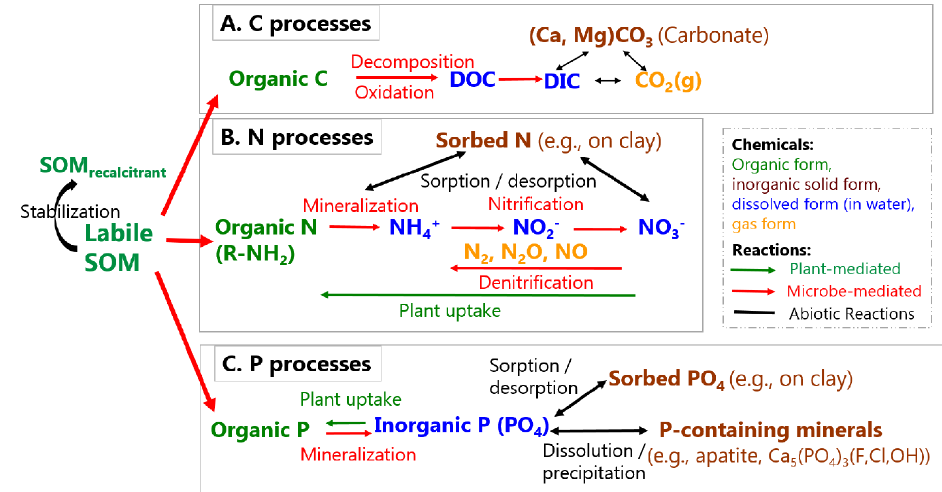
Figure 3. Biotic and abiotic reactions relevant to the transformation of soil organic matter (SOM). SOM can become stabilized (recalcitrant) through sorption on clay and separation from reactants. Labile OM can decompose into inorganic forms, releasing C, N, and P that further transform into various forms (taken from Li, 2019, with permission from the Mineralogical Society of